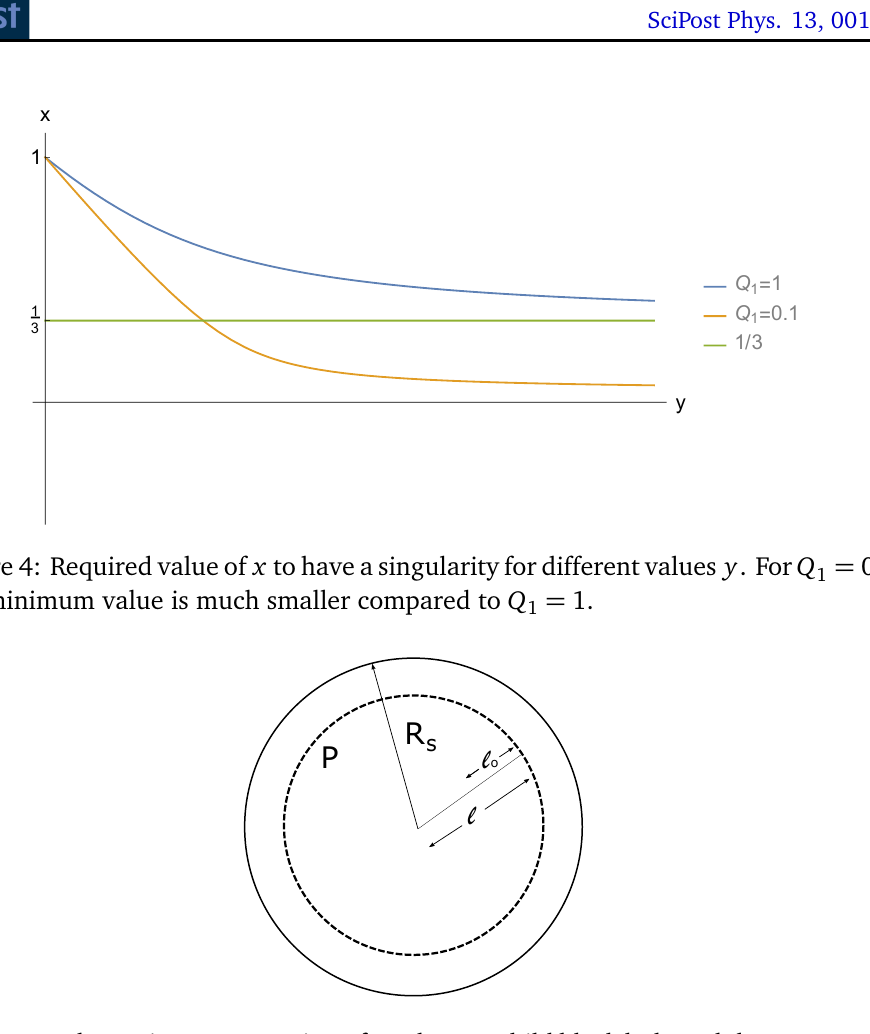
Figure 5: Schematic representation of a Schwarzschild black hole and the parameters in scenario 1. The dashed circle is constant r and t hypersurface P . Distance (cid:96) measured from the hypersurface P until the NEC starts being violated. Distance (cid:96) is from P to the singularity (pictured here at r =